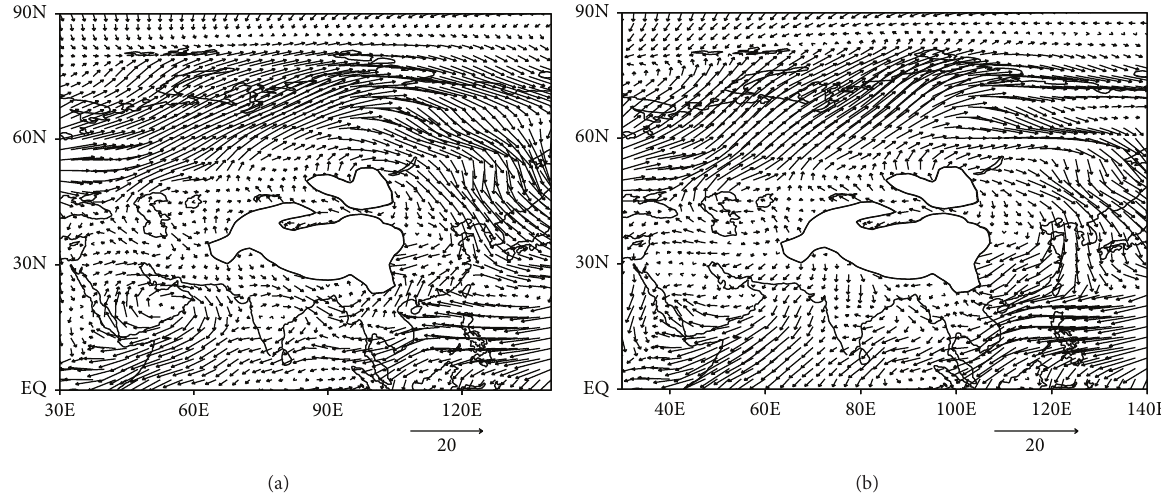
Figure 9: Wind field departure from January 11 to 30, 2008, at 850 hPa (a) and 925 hPa (b) (unit: m/s).